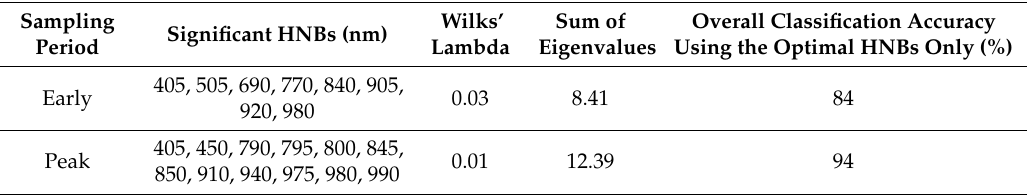
Table 3. Top ten percent of significant hyperspectral narrowbands (HNBs) for all four vegetation communities and overall classification accuracy of the linear discriminant analysis (LDA) using the optimal HNBs. All Wilks’s lambda values are significant ( p <